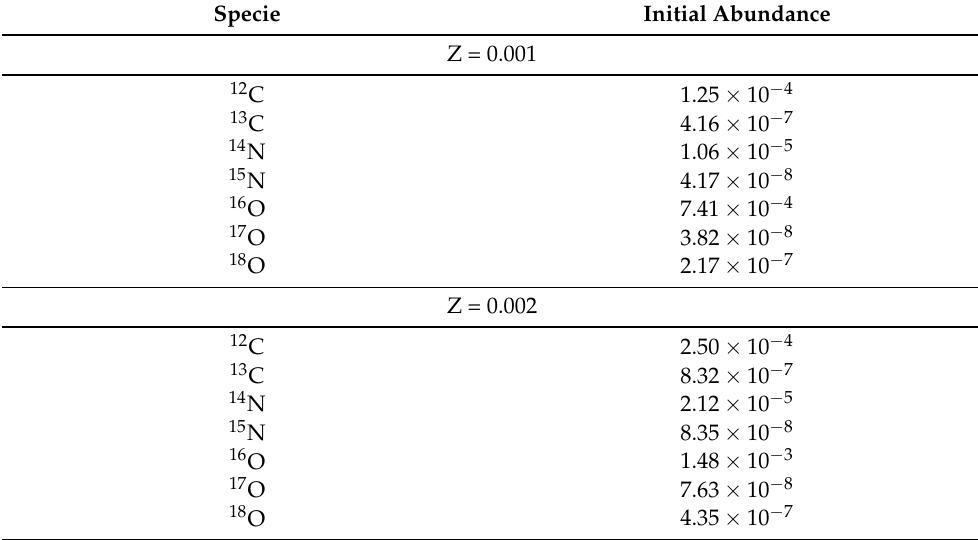
Table 1. Initial CNO abundances in mass fractions adopted for the stellar models presented in Tables 2 and